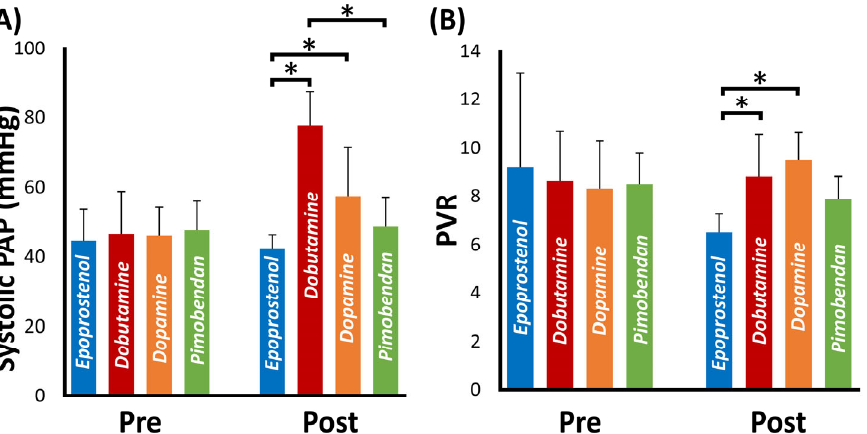
Figure 1. Results of systolic pulmonary arterial pressure (PAP) and pulmonary vascular resistance (PVR) before and after administration of various cardiac drugs at the maximal doses. Blue, red, orange and green bars represent the results of epoprostenol (20 ng/kg/min), dobutamine (10 µg/kg/min), dopamine (10 µg/kg/min) and pimobendan (0.15 mg/kg), respectively. * These values were significantly different ( p < 0.05) based on the Bonferroni-adjusted Student’s t test (normally distributed data) or the Bonferroni-adjusted Mann-Whitney U test (non-normally distributed data).